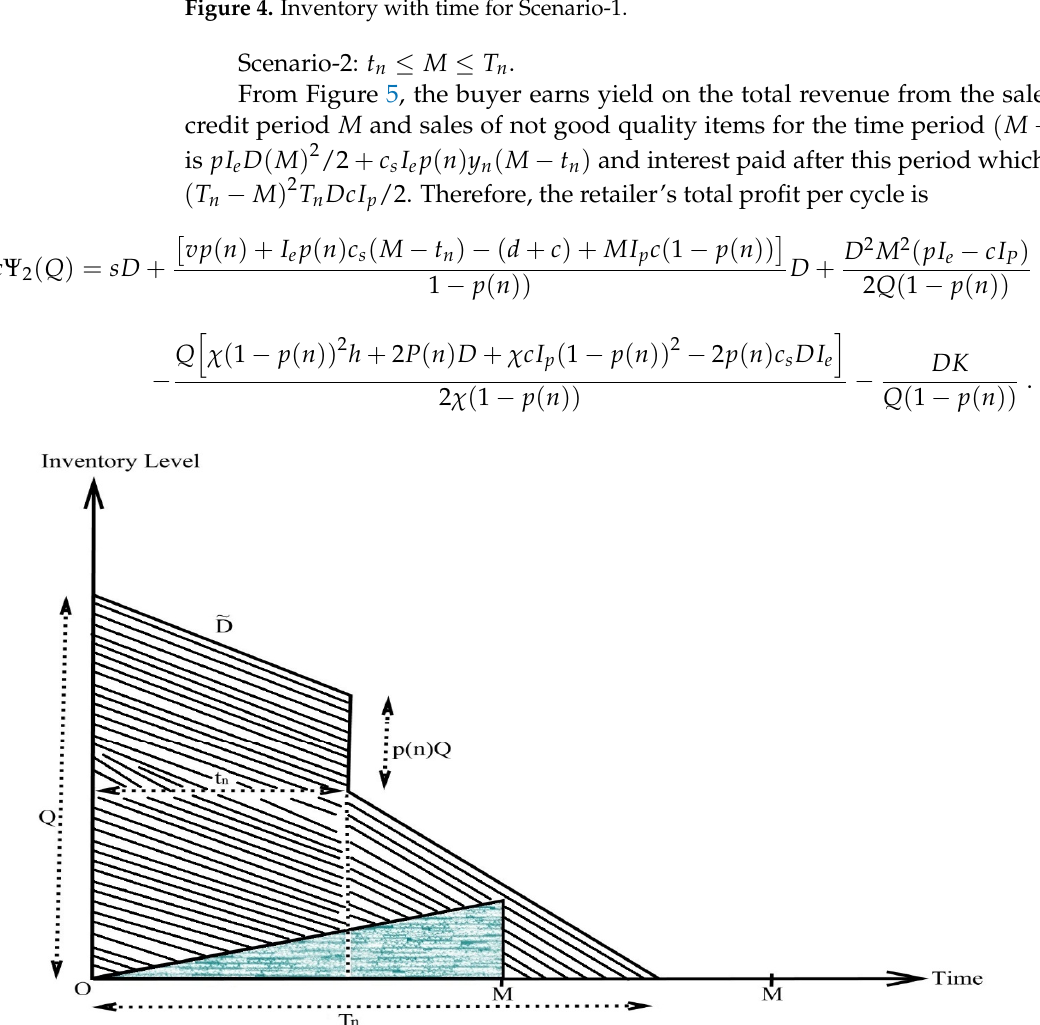
Figure 4. Inventory with time for Scenario-1.